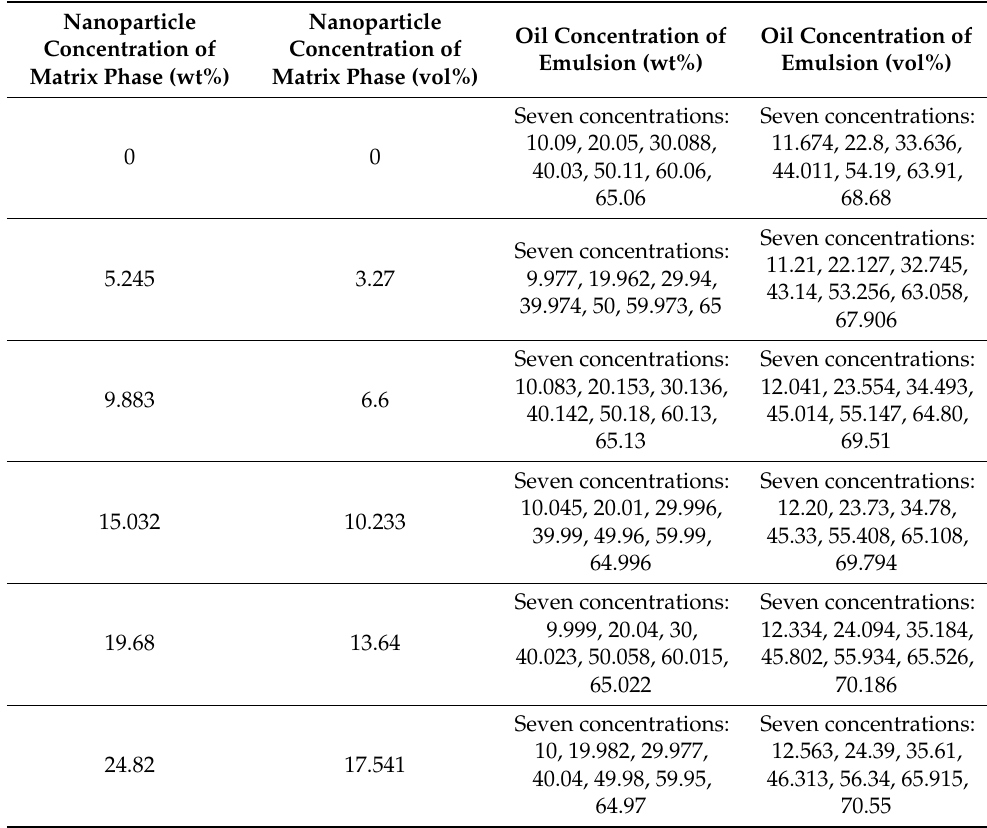
Table 2. Compositions of emulsions investigated in this